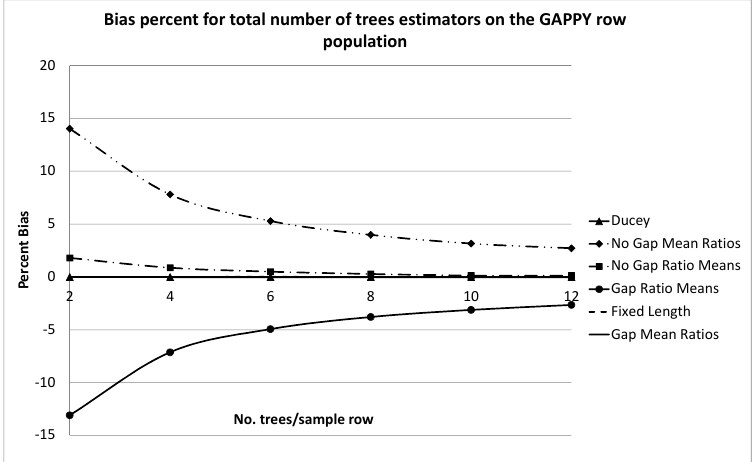
Figure 8. Bias percentages on the GAPPY row population for the total number of trees estimated by Ducey’s estimator, ¯ˆ Y D , shown in Equation (7); the “No Gap Mean Ratios” estimator, ˆ Y NG − MR , shown in Equation (17); the “Gap Mean Ratios” estimator, ˆ Y G − MR , shown in Equation (12); the “No Gap Ratio Means” estimator, ˆ Y NG − RM , shown in Equation (11); the “Gap Ratio Means” estimator, ˆ Y G − RM , shown in Equation (10); and fixed length row sampling for 10 random sample locations and numbers of trees per sample, ranging from two to